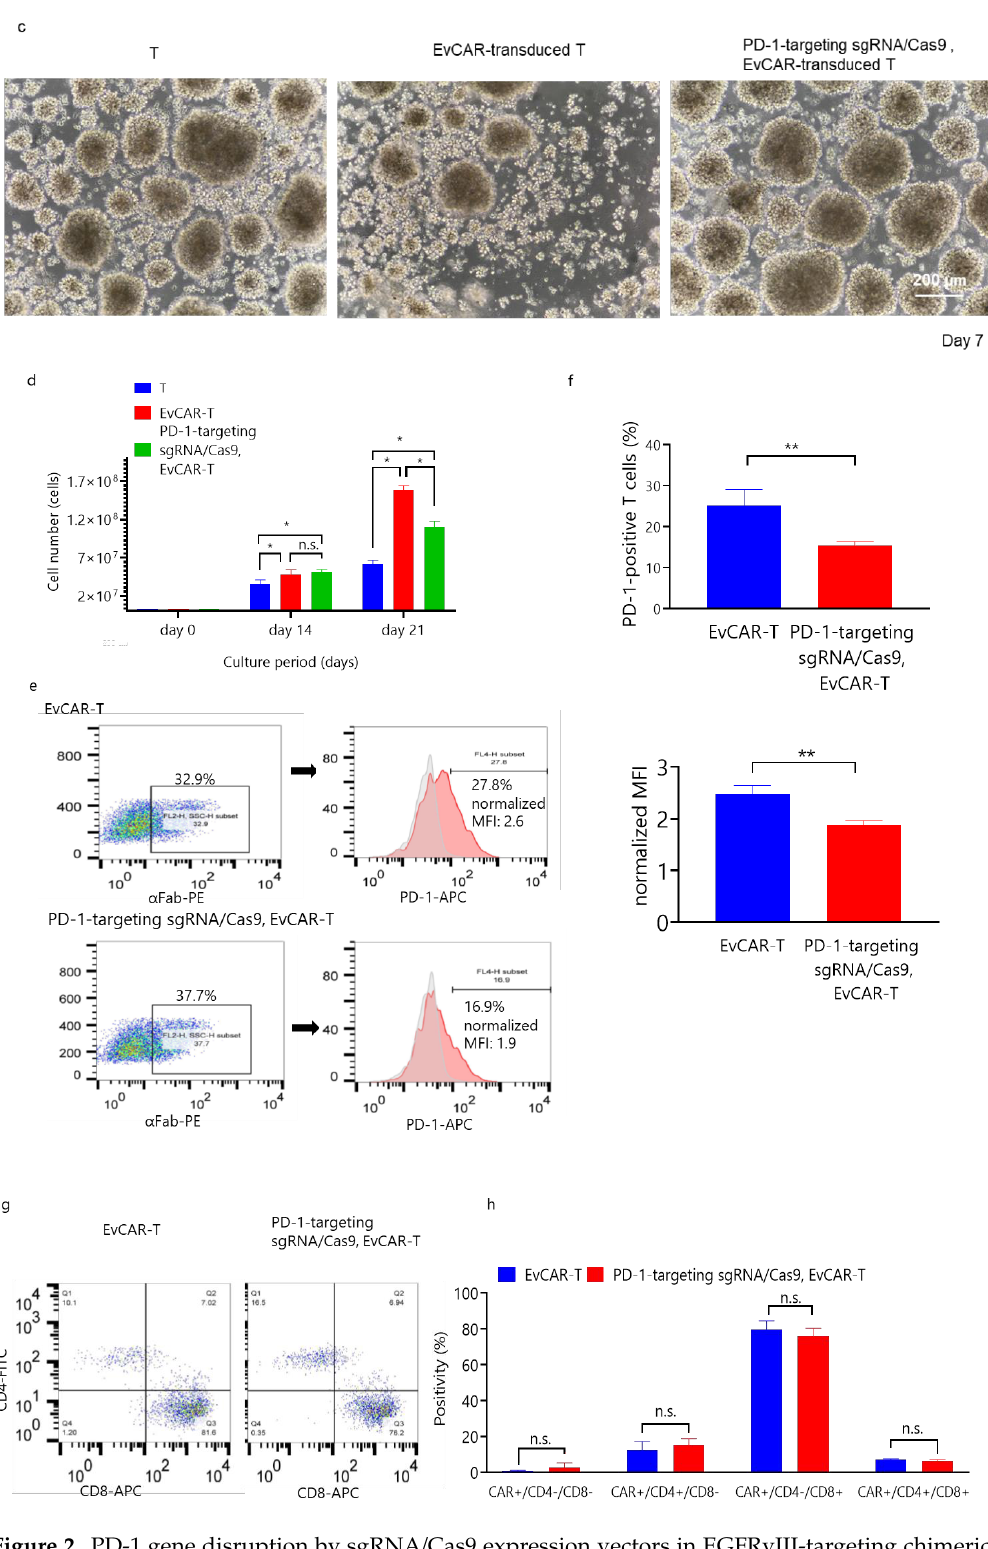
Figure 2. PD-1 gene disruption by sgRNA / Cas9 expression vectors in EGFRvIII-targeting chimeric antigen receptor (EvCAR-T) cells derived from human peripheral T cells. ( a ) Schematic representation of the procedure for introducing PD-1 sgRNA / Cas9 expression vectors and EvCAR into human T cells. ( b ) Transfection e ffi cacy of PD-1-targeting sgRNA / Cas9 expression vectors. The upper and lower panels depict the electroporation of control pmaxGFP vectors and PD-1-targeting sgRNA / Cas9 expression vectors in human T cells, respectively. The images were acquired under a phase contrast